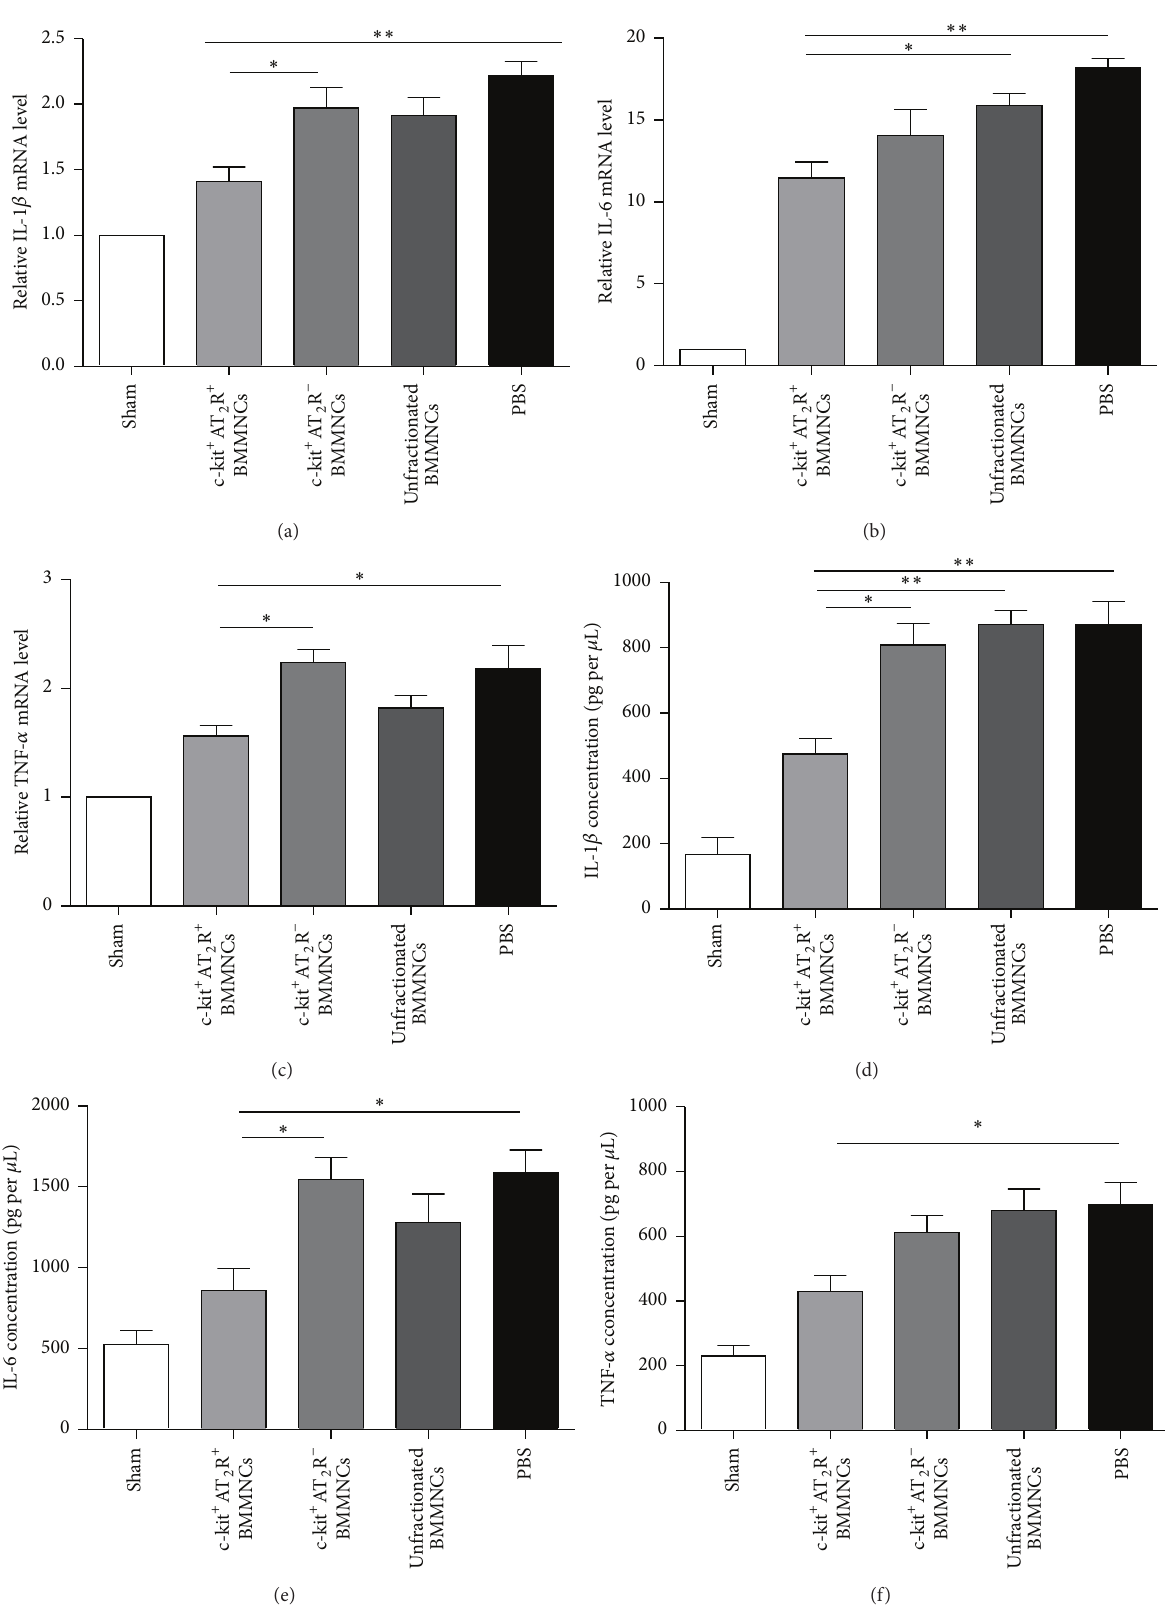
Figure 7: Expression of inflammatory factors in heart tissue. ((a)–(c)) Real-time PCR of IL-1 𝛽 , IL-6, and TNF- 𝛼 mRNA expression level in heart tissues ( ∗ 𝑝 < 0.05, ∗∗ 𝑝 < 0.01; 𝑛 = 3 for each group). ((d)–(f)) protein expression level of IL-1 𝛽 , IL-6, and TNF- 𝛼 in supernatants of heart tissue homogenates ( ∗ 𝑝 < 0.05, ∗∗ 𝑝 < 0.01; 𝑛 = 3 for each